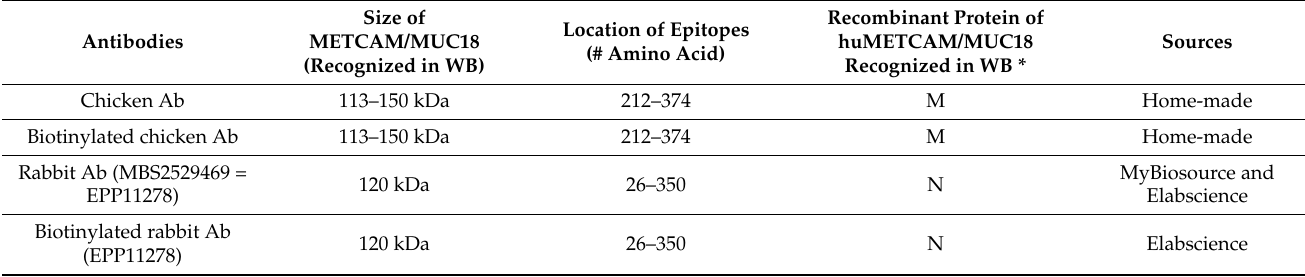
Table 1. Epitopes recognized by various